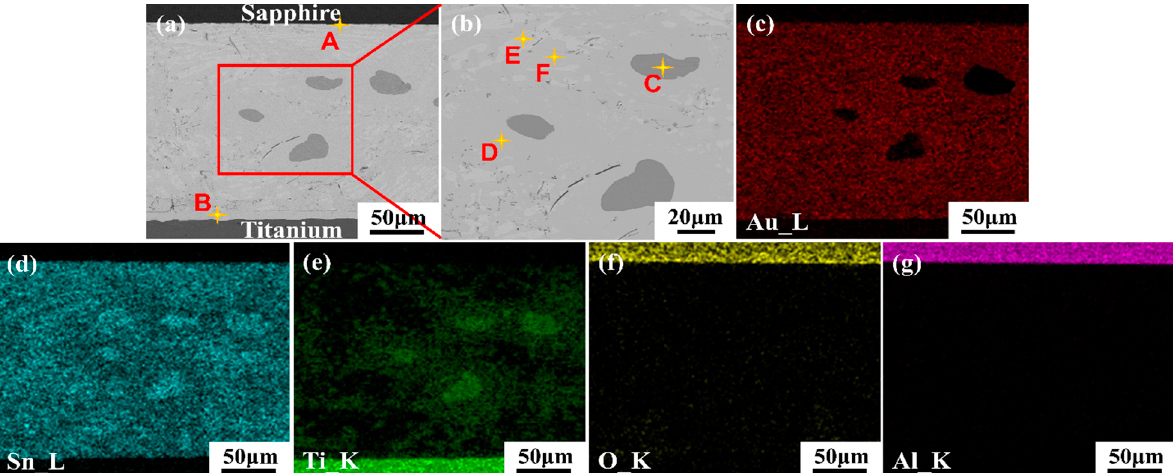
Figure 4. Analyses of the titanium/AuSn20/Sn-3Ti/sapphire joint brazed at 550 °C for 30 min: ( a ) typical interfacial microstructure; ( b ) the high-magnification image of the brazing seam; and ( c – g ) element map distributions of Au, Sn, Ti, O, and Al.